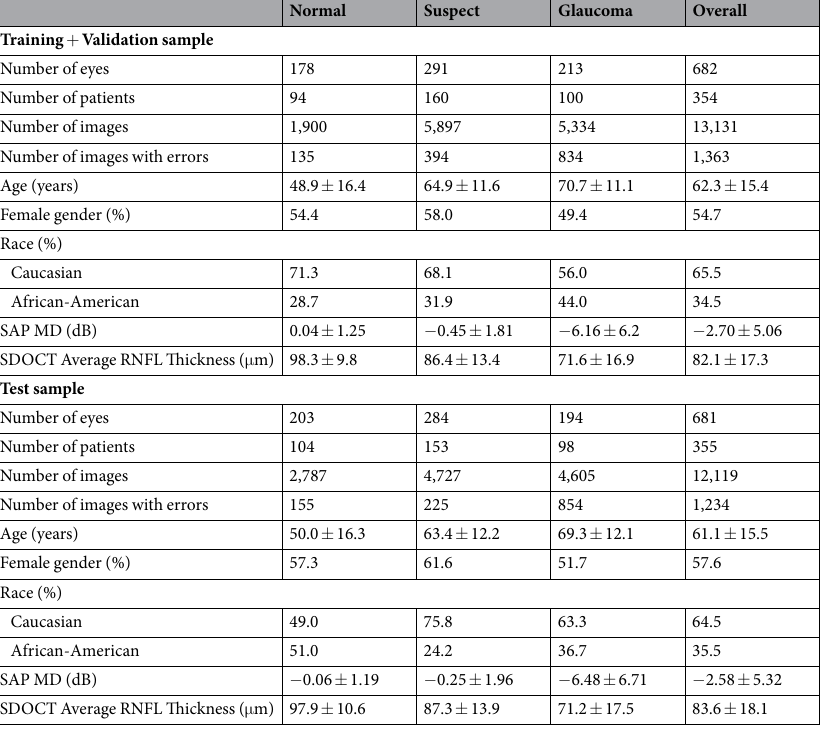
Table 1. Demographic and clinical characteristics of the eyes and subjects included in the training and test samples by randomization at the patient level. SAP = Standard Automated Perimetry; MD = Mean